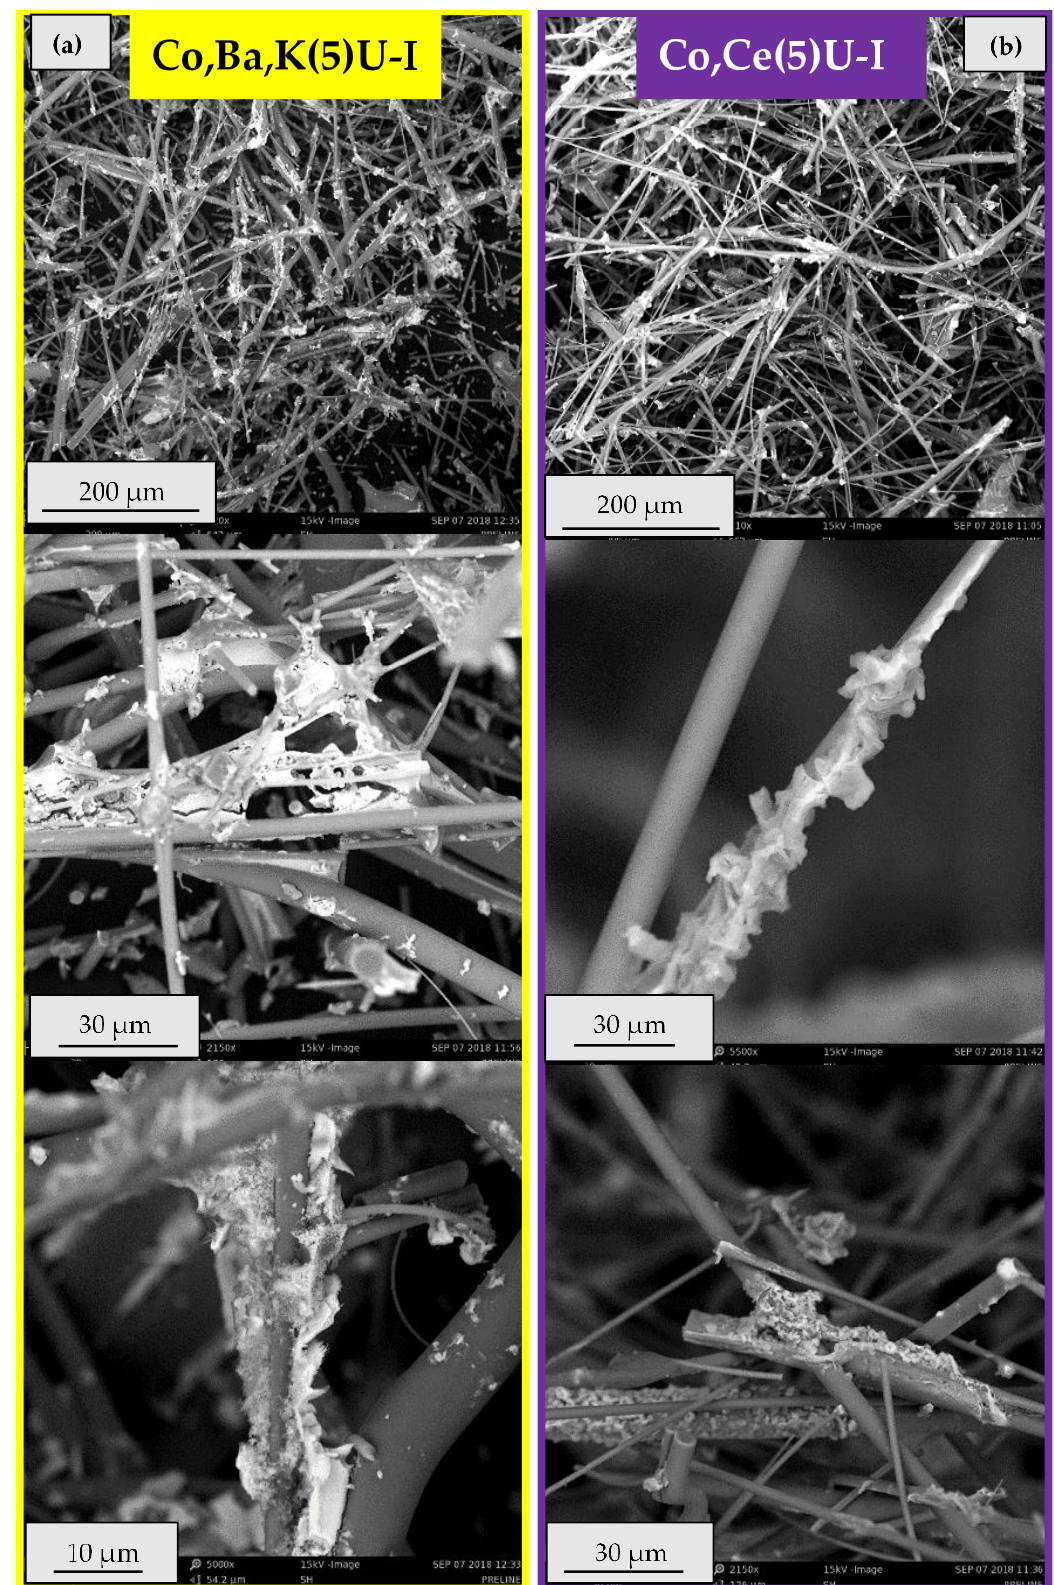
( b ) Figure 6. Morphology of catalytic ceramic papers with 5% active phase ( a ) Co,Ba,K(5)U-I and ( b ) Co,Ce(5)U-I.